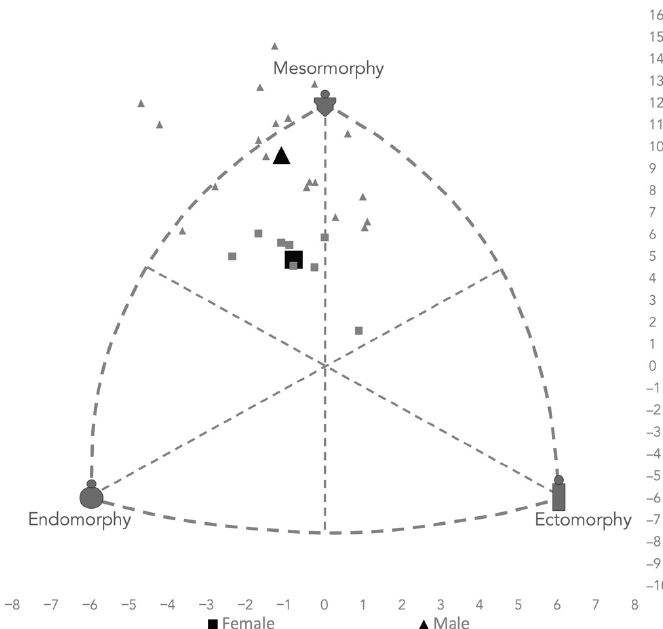
Figure 2. Somatochart of the entire sample and mean values. Note: The small shapes represent the individual values of the sample, and the large ones, the mean values.